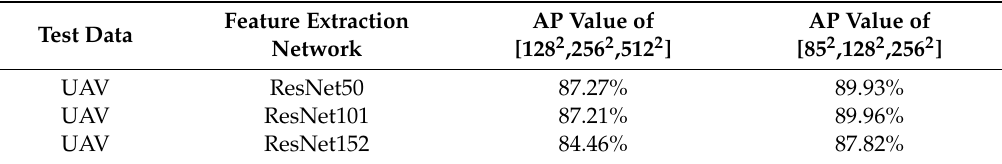
Table 2. Model test results with different anchor sizes.